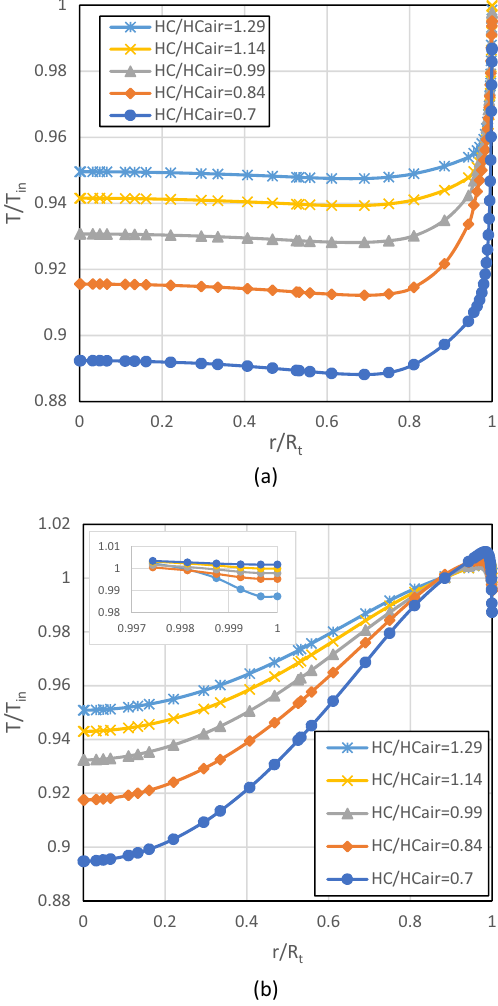
Fig. 15 Dimensionless pressure profiles versus dimensionless radial direction plotted at z∕L = 0.63 for various heat capacity ratios. a Static and b total pressures with 400 kPa at the inlet, 0 kPa at the cold outlet and 30 kPa at the hot outlet